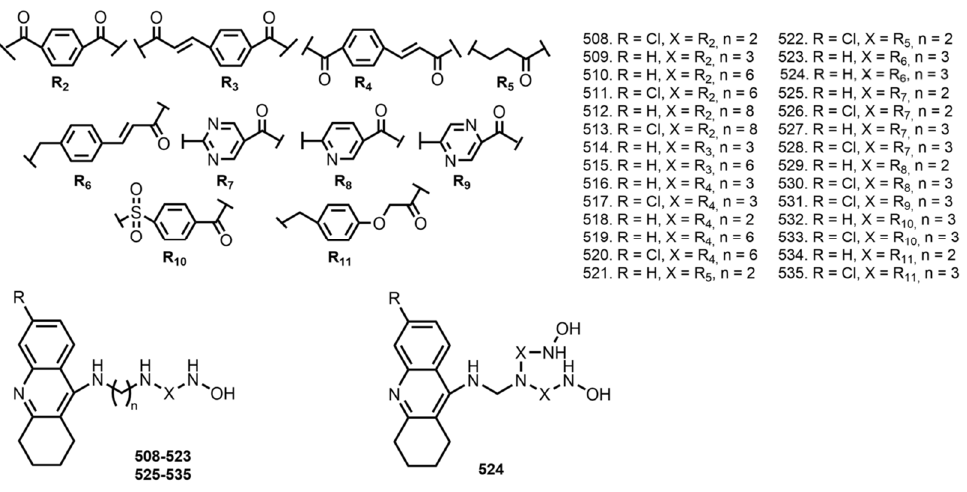
Figure 20. THA (6 ‐ Cl ‐ THA) ‐ HDAC inhibitors hybrids 508 – 535 [87]. Figure 20. THA (6-Cl-THA)–HDAC inhibitors hybrids 508 – 535